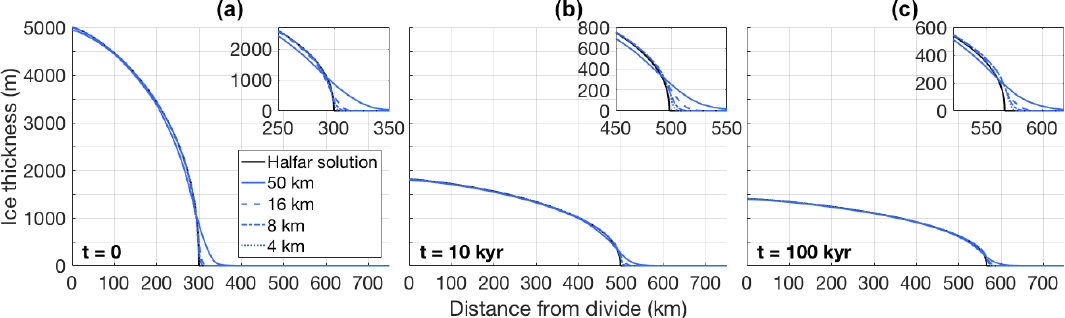
Figure 2. The evolution through time of a schematic, radially symmetric, isothermal ice sheet, as simulated by UFEMISM at different ice-margin resolutions, compared to the Halfar solution starting at t = t 0 . The small sub-panels in the top-right corner of the panels show a zoomed-in view of the ice margin, showing how the simulated ice margin converges to the analytical solution as the model resolution increases.